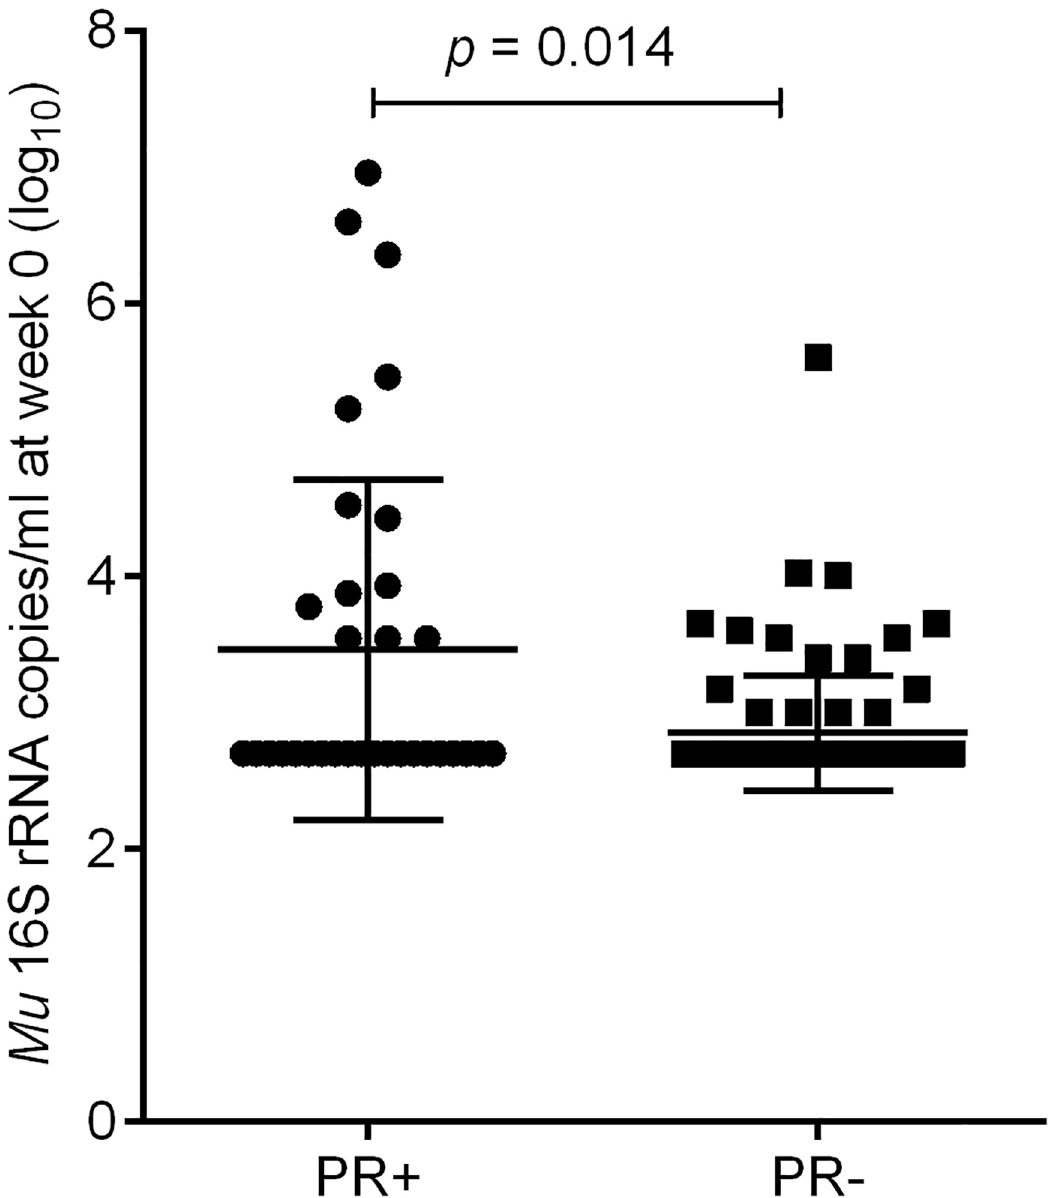
Fig 3. Increased bacterial load at baseline in patients who developed paradoxical reaction (PR+) in comparison to those who did not (PR-). Higher viable M . ulcerans in lesions of patients who subsequently developed paradoxical reaction post treatment as measured by 16S rRNA at baseline compared those who did not. Each point represents the number of copies per milliliter (log 10 ) of sample. The horizontal bars show the means and standard deviations of each